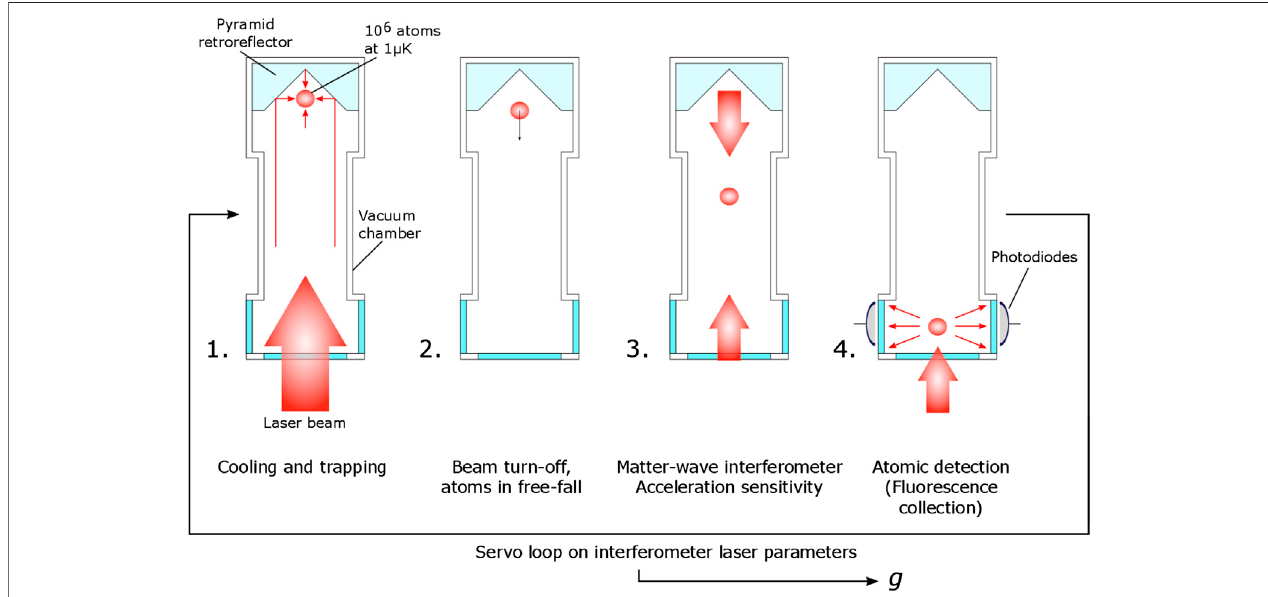
FIGURE6| Illustrationofatypicalmeasurementsequencewiththeabsolutequantumgravimeter.1.Atomsaretrappedandlaser-cooledinsideahollowpyramidal re fl ectorlocatedatthetopofthevacuumchamber.2.Laseristurnedoff,andtheatomsareinfree-fall.3.Ramanlaserpulsesareusedtomeasuretheaccelerationofthe atoms with respect to the vacuum chamber. At the output of this matter-wave interferometer, the acceleration is encoded on the atomic populations of two quantum states. 4. Fluorescence detection is used to readout the number of atoms in each quantum state and derive the value of acceleration.